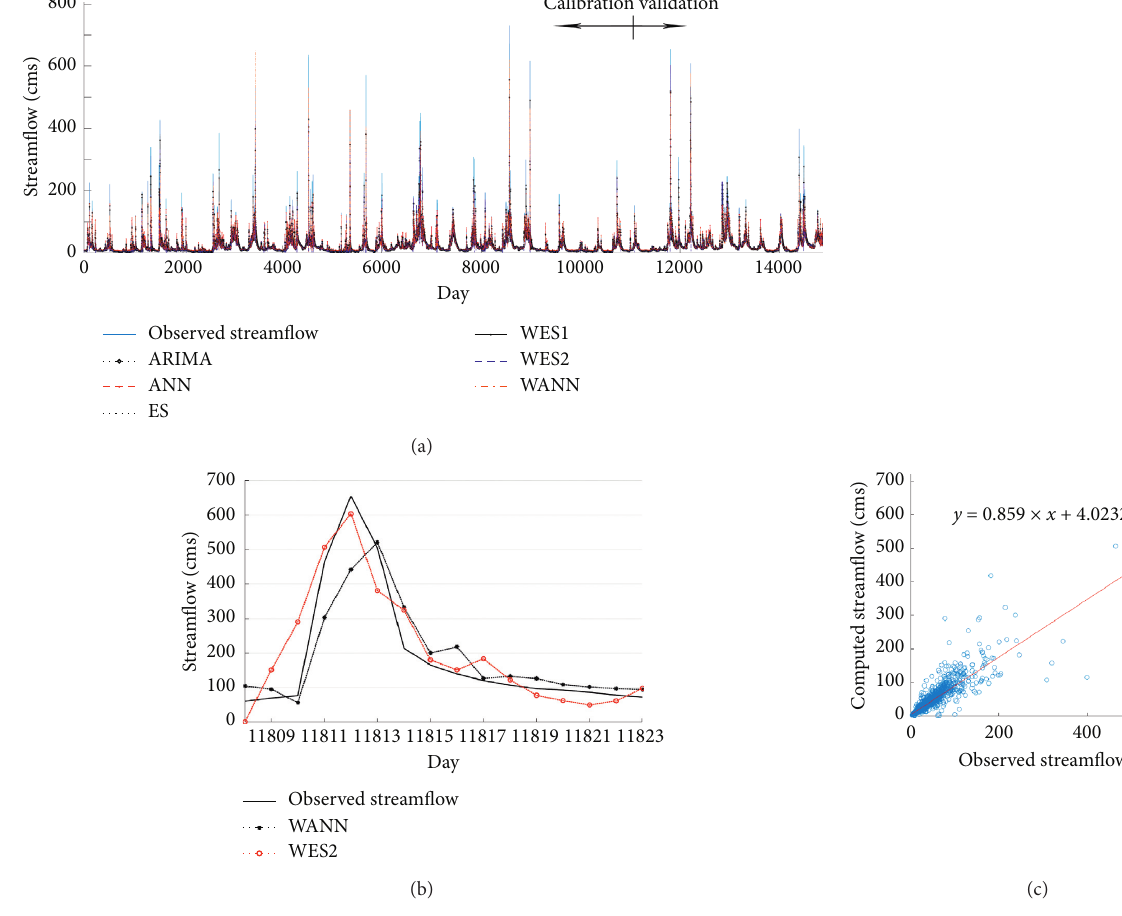
Figure 6: Observed/simulated daily streamflow of West Nishnabotna. (a) Whole. (b) Detail. (c) Verification scatter plot of WES